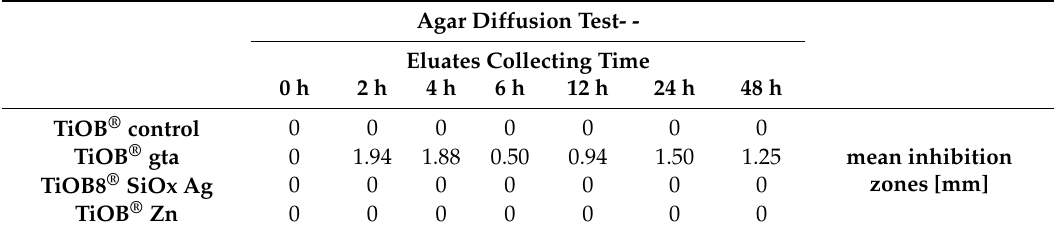
Table 2. Inhibition of Staphylococcus aureus in an agar diffusion test by eluates collected from the functionalized surfaces after 0, 2, 4, 6, 12, 24, and 48 h. Agar Diffusion Test-